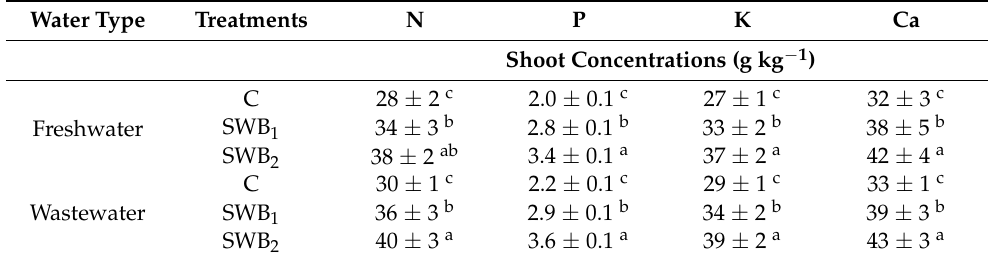
Table 6. Effect of shrimp-waste-derived biochar (SWB) rates on nitrogen (N), phosphorous (P), potassium (K), and calcium (Ca) concentrations in plant shoot. C, SWB 1 , and SWB 2 are 0, 1, and 2% ( w / w ) of biochar. Means ( ± SD, n = 5) with different letters indicate significant differences. Water